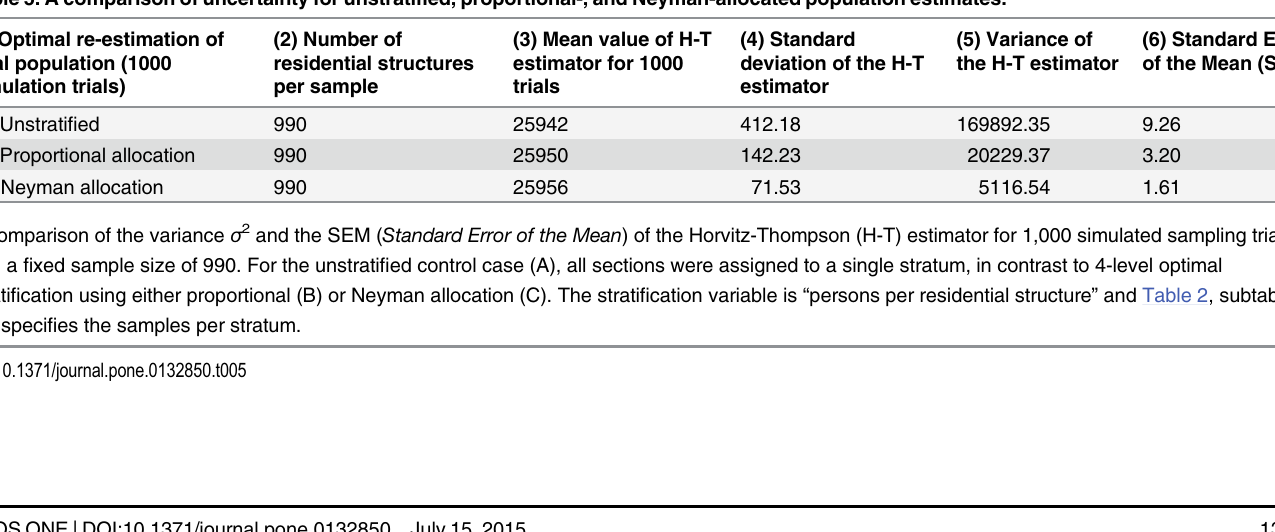
Strati fi cation variable: “ residential structures per